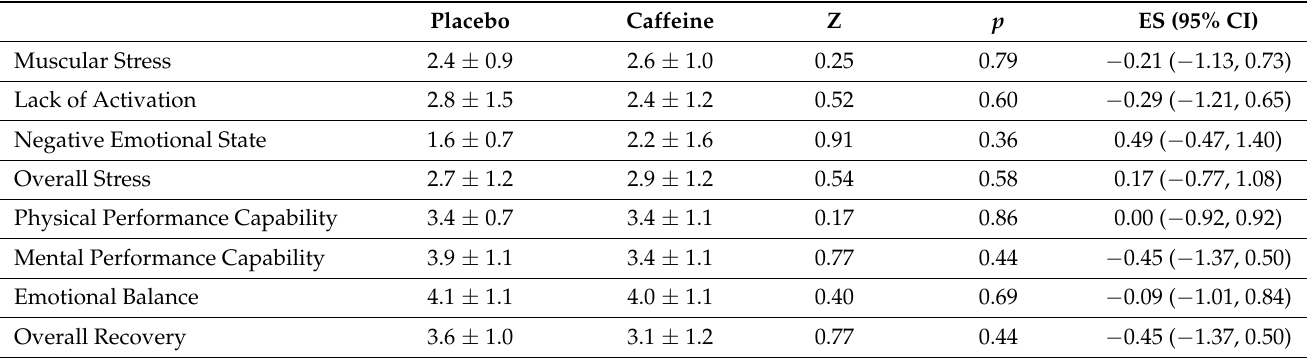
Table 3. Results of short recovery and stress scale for caffeine and placebo